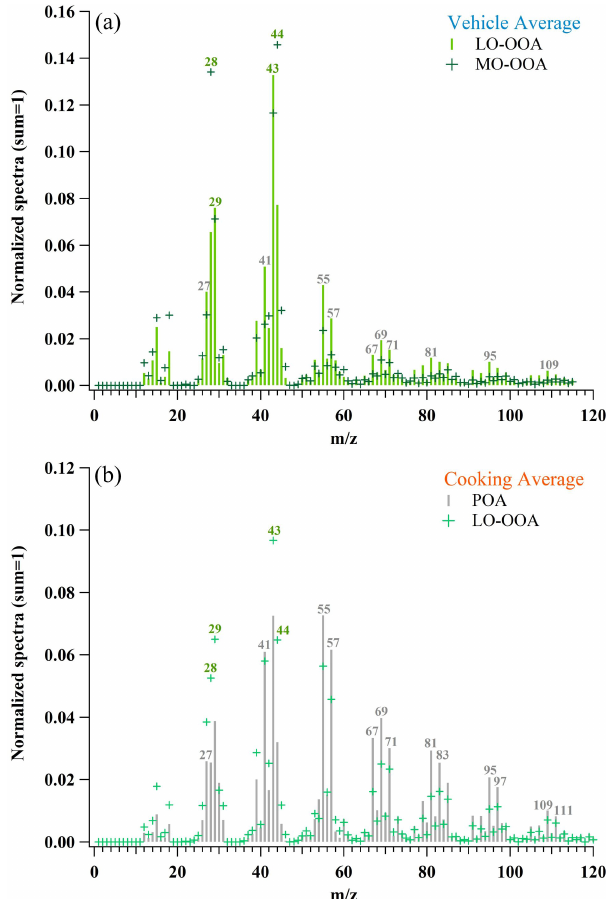
Figure 6. Average mass spectra of OAs from two urban-lifestyle sources. The numbered symbols represent the m/z values with rel- atively large fractions. The gray symbols represent the fragments that mainly come from hydrocarbon-like fragments, and the green symbols represent those that mainly come from oxygen-containing fragments. The mass spectra are determined by an HR-ToF-AMS. The average data are shown in the figure.